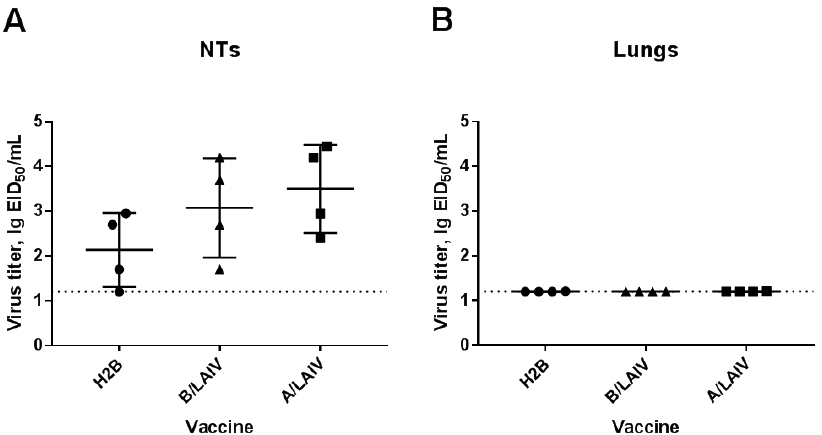
Figure 5. Titers of the studied LAIV viruses in lungs and nasal turbinates (NTs) of C57BL/6J mice on day 3 after immunization (mean ± SD): ( A ) titers in nasal turbinates on day 3 post-immunization and ( B ) titers in lungs at day 3 post-immunization.